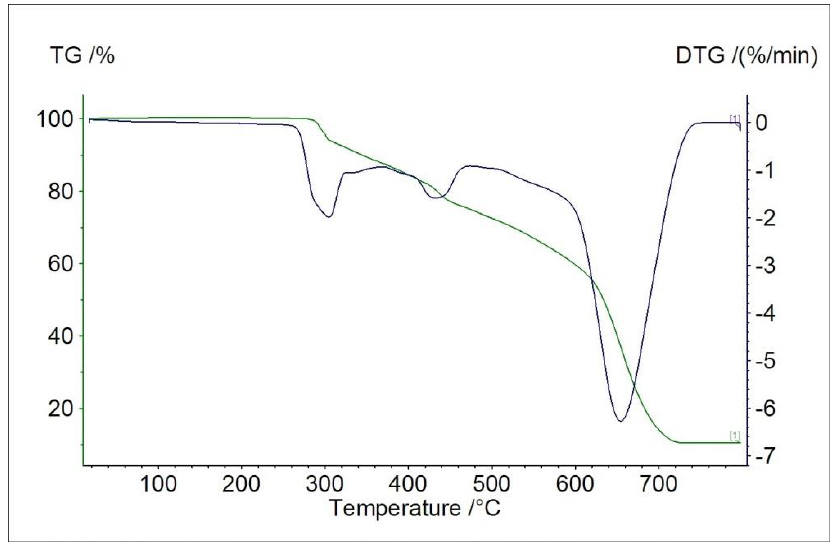
Figure 7. TG (green) and DTG (blue) curves showing Zn(L)Cl 2 compound decomposition pattern in air.